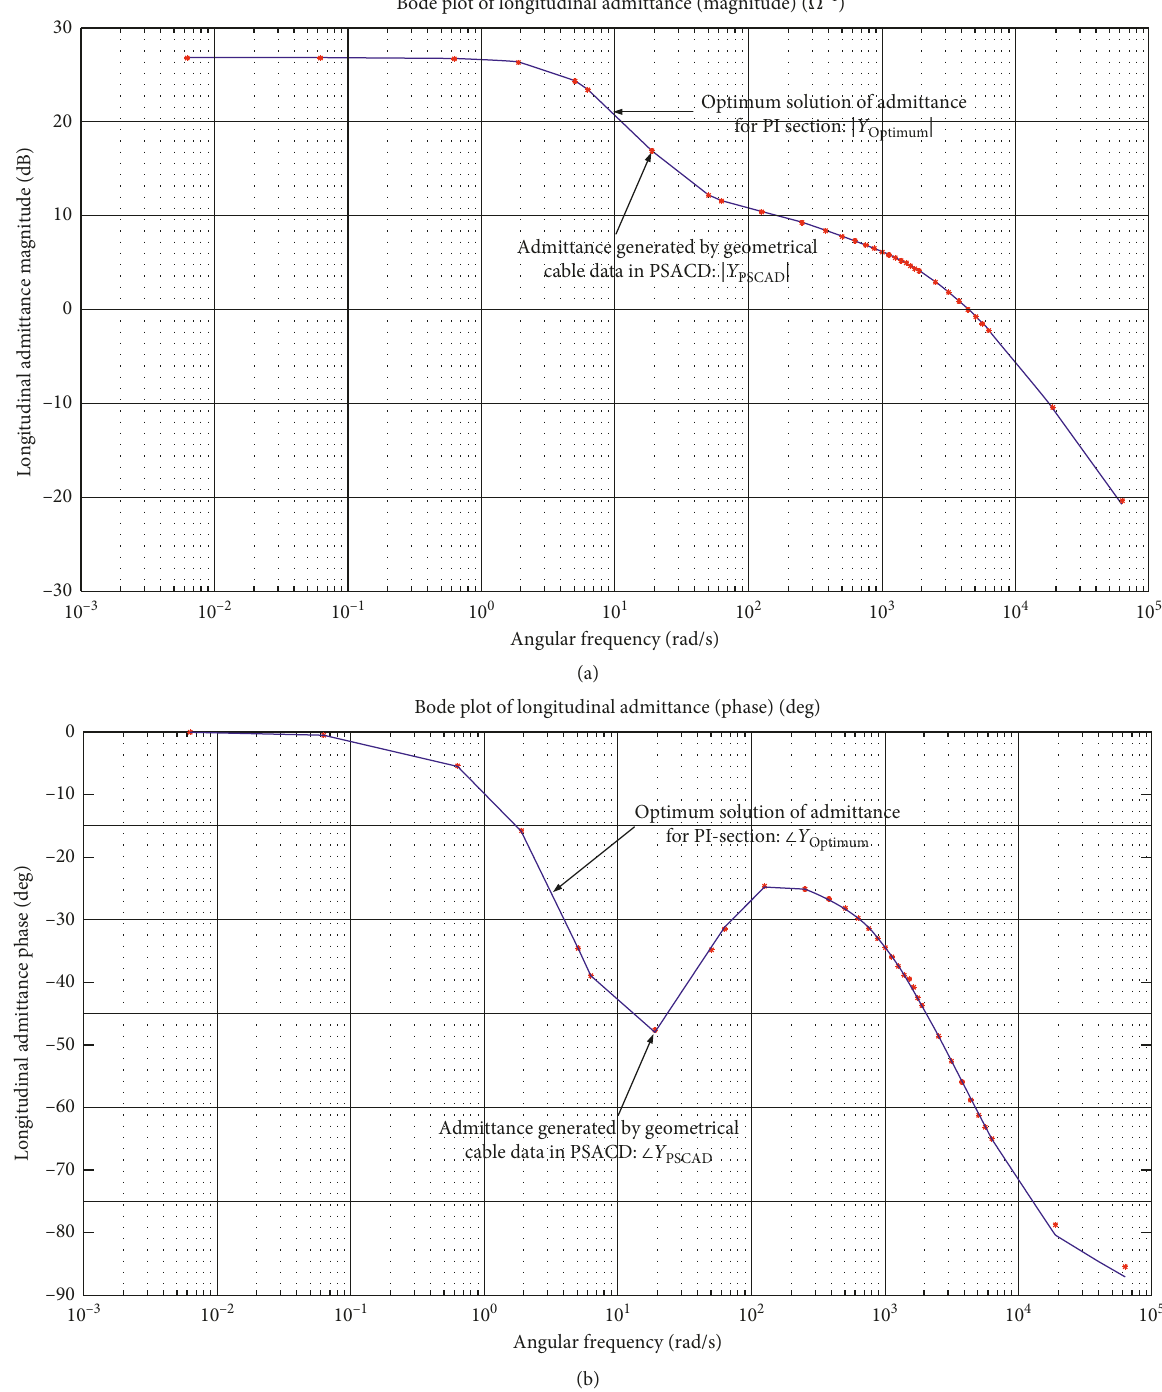
Figure 16: Results of the optimum vector fitting for the longitudinal admittance of the submarine array cable with the parallel of eight RL series branches. The longitudinal admittance values found in PSCAD are highlighted in red star (points), while the admittance of the parallel of the eight series RL branches is depicted in blue curve (line). (a) Magnitude of calculated admittance. (b) Phase angle of calculated